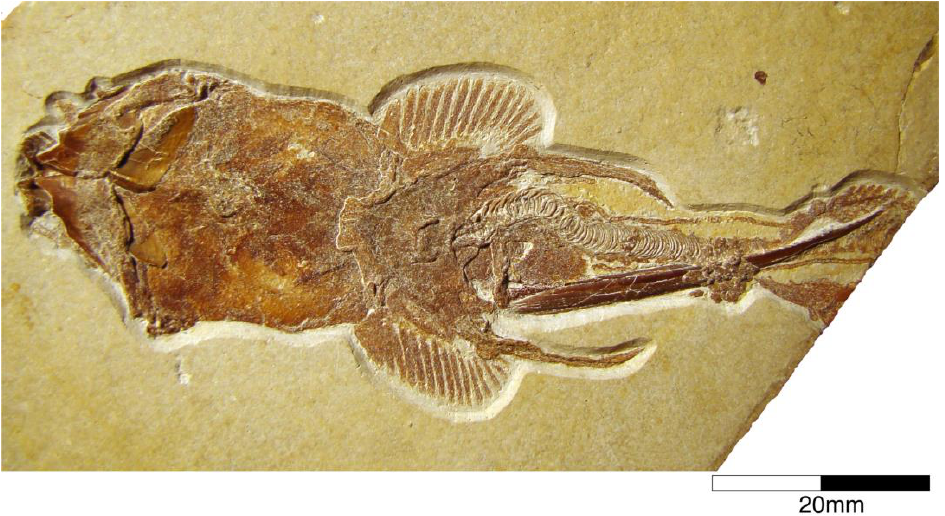
Figure 5. Still undescribed, juvenile specimen of † Ischyodus egertoni (Buckland, 1936 [101]) (NMB without number) from the late Kimmeridgian Torleite Formation of Wattendorf in the northern part of the Franconian Alb.